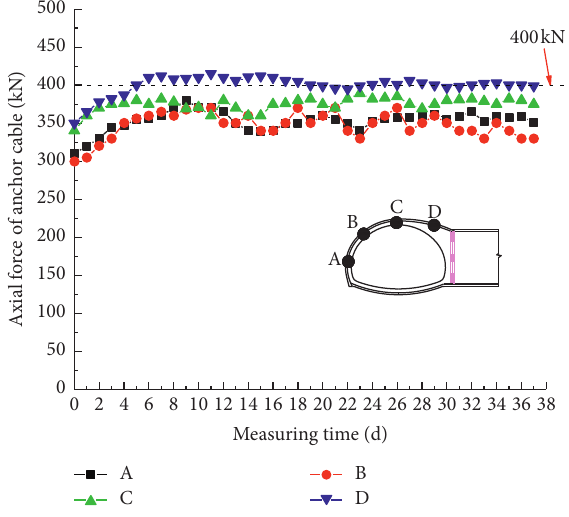
Figure 23: Axial force of anchor